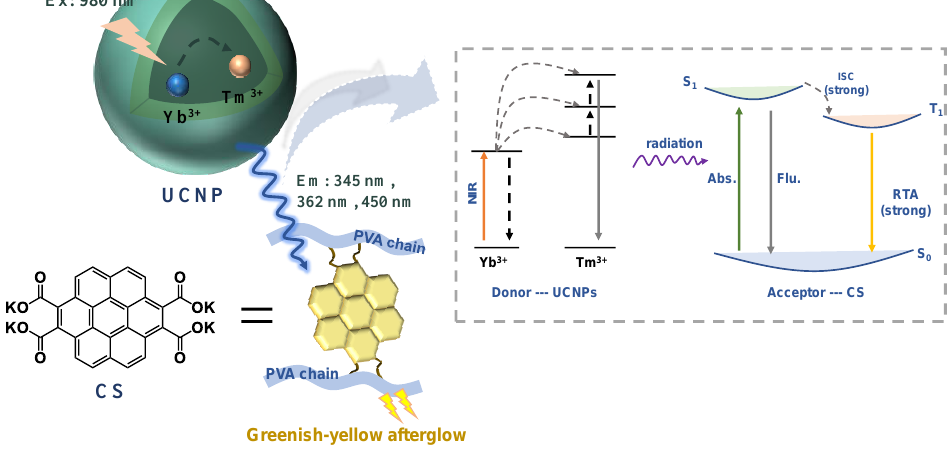
Figure 1. Simplified illustration of the radiation energy transfer between donor UCNPs and acceptor CS under NIR excitation. (Abs. = absorbance, Flu. = fluorescence, ISC = intersystem